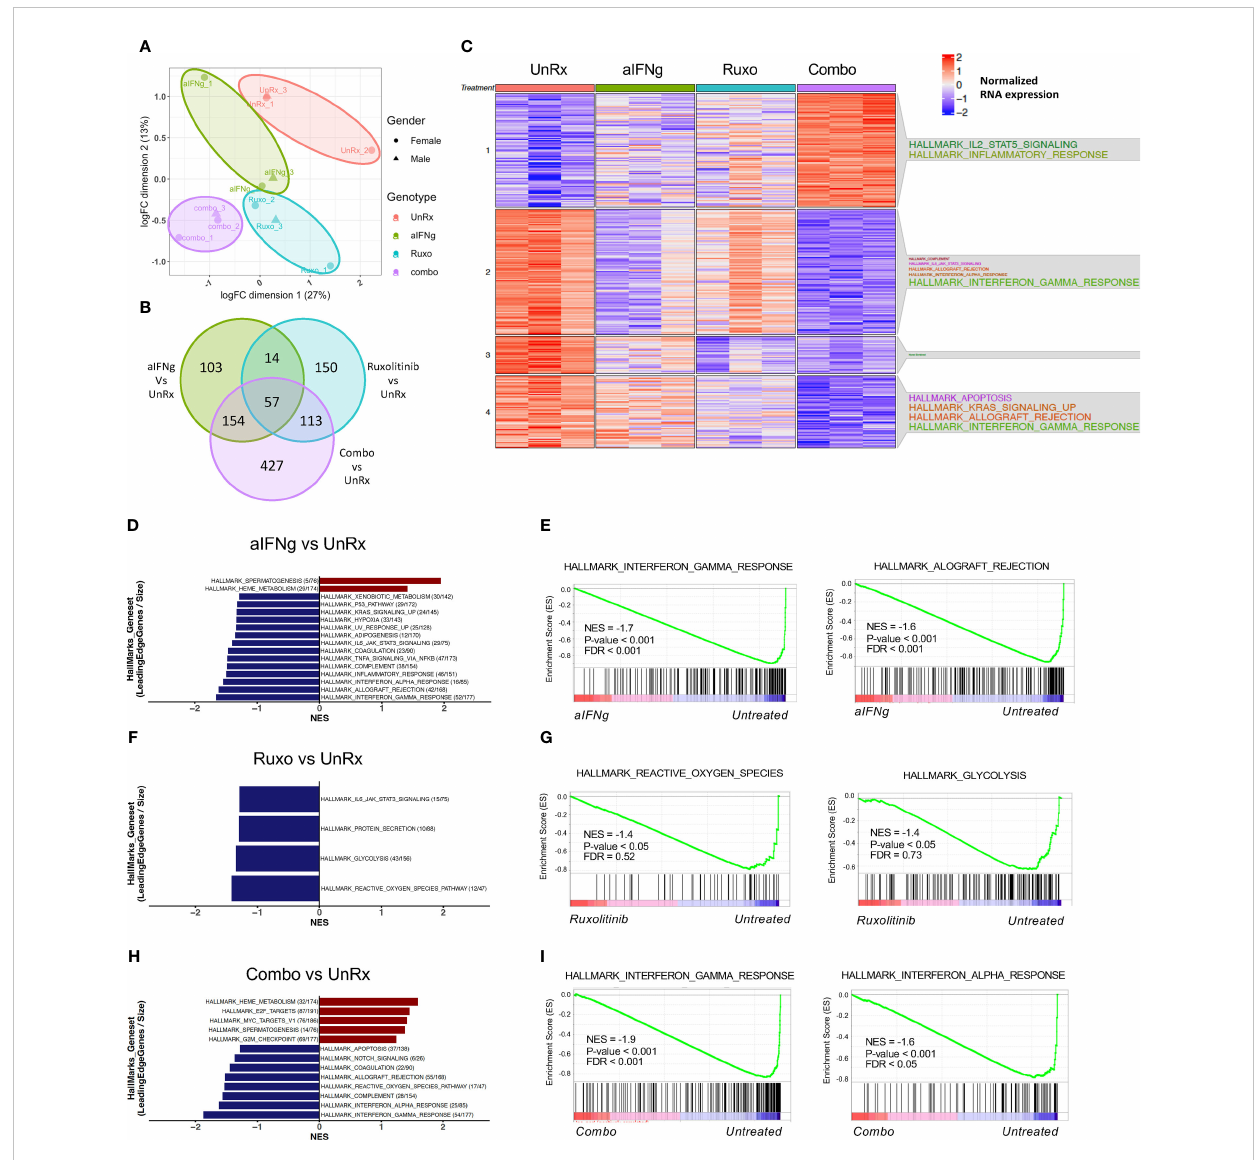
FIGURE 4 Changes in transcriptional pro fi les of splenic CD8 T cells from Prf1 − / − mice infected with LCMV and treated with aIFNg, ruxolitinib, or combination treatment. (A) Unsupervised clustering using multidimensional scaling (MDS) of CD8 T cells infected with LCMV and left untreated (red) or treated with aIFNg (green), ruxolitinib (blue), or both agents (purple; 3 mice per group). (B) Venn diagram depicting the numbers of differentially expressed genes (DEGs) in aIFNg vs. UnRx, ruxolitinib vs. UnRx, combination vs. UnRx groups ( P- value < 0.05, LogFC >1). (C) Heatmap of the signi fi cant DEGs in naïve, UnRx, aIFNg, ruxolitinib, and combination treatment groups annotated with enriched hallmark gene sets within each cluster. Bar graphs of GSEA demonstrating the most signi fi cant (P-value < 0.05 or P-value < 0.1 & normalized enriched score (NES) >1) hallmarks gene sets in CD8 T cells from LCMV-infected aIFNg-treated vs. UnRx mice (D) , LCMV-infected ruxolitinib-treated vs. UnRx mice (F) , or LCMV-infected combination treated vs. UnRx mice (H) . Enrichment plots highlighting the most signi fi cant pathways downregulated in CD8 T cells from LCMV-infected aIFNg-treated vs. UnRx mice (E) , LCMV-infected ruxolitinib-treated vs. UnRx mice (G) , or LCMV-infected combination treatment vs. UnRx mice (I)